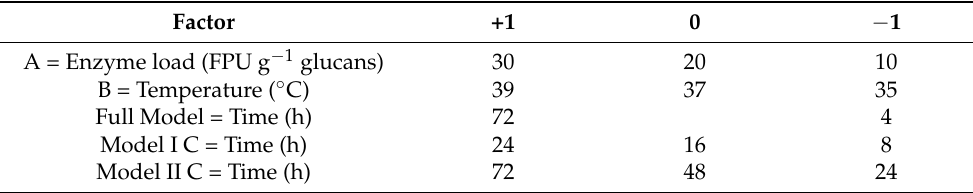
Table 1. The variable operating conditions of the SSF